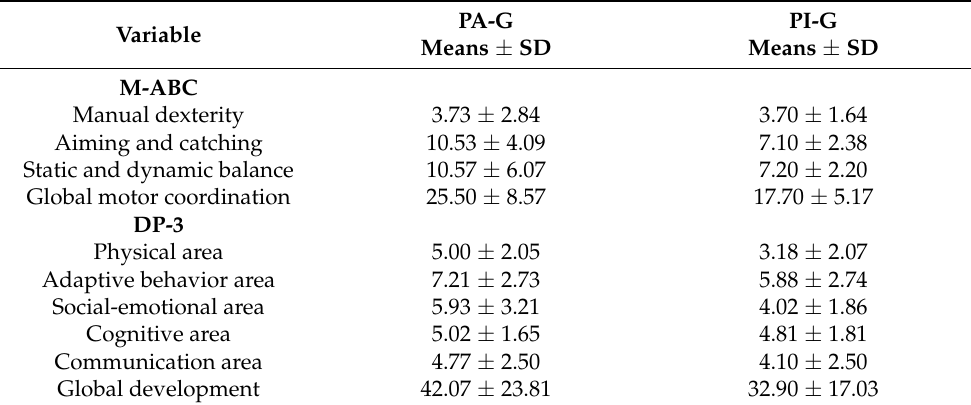
Table 2. Descriptive statistics of the PA-G and the PI-G.